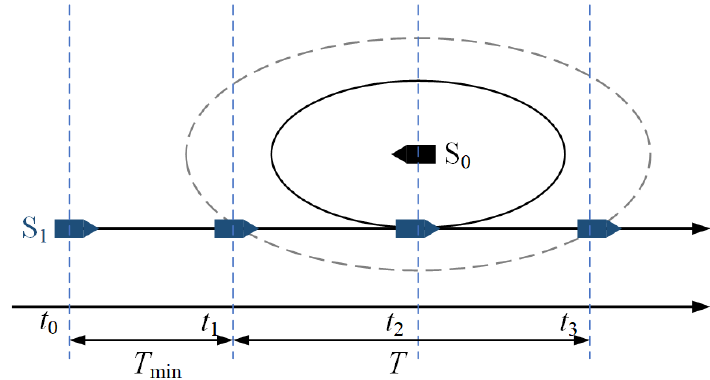
Figure 7. Schematic diagram of collision risk parameters.